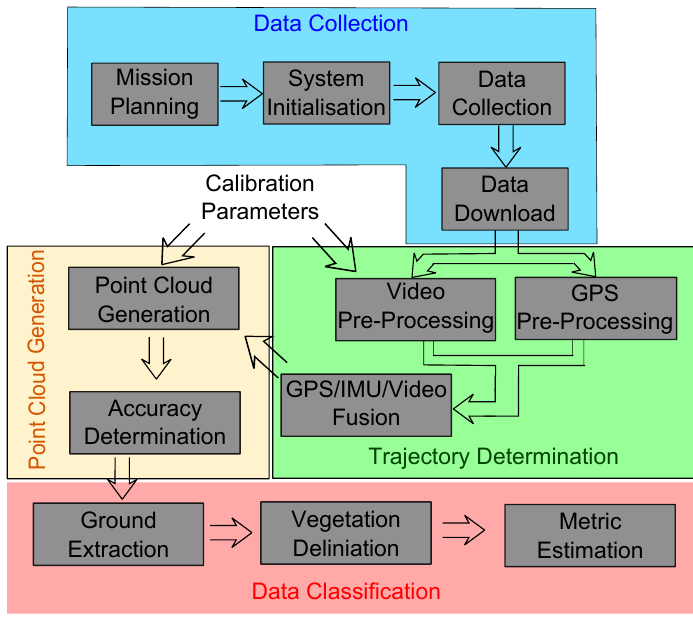
Figure 2. The modified LiDAR workflow to be used in producing a point cloud from the UAV